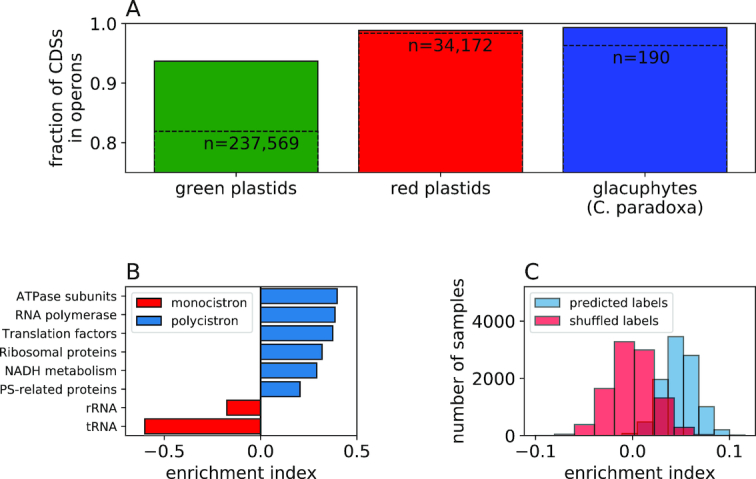
General traits of plastid primary transcripts. (A) The fraction of CDSs and total genes (dashed line) found in operons in green plastids, red plastids and glacuphytes. All differences return a non-significant empiric P-value of > \documentclass[12pt]{minimal}
\usepackage{amsmath}
\usepackage{wasysym} 
\usepackage{amsfonts} 
\usepackage{amssymb} 
\usepackage{amsbsy}
\usepackage{upgreek}
\usepackage{mathrsfs}
\setlength{\oddsidemargin}{-69pt}
\begin{document}
}{}$0.8$\end{document} (see ‘Materials and Methods’ section: Empiric P-value). The total number of genes sampled in each group is given above the relevant bar. The bars show mean ± SE. (B) Operon enrichment in different gene classes. Additionally, a hypergeometric enrichment/depletion P-value was computed for each group; P < 10−300 for all groups. (C) The distribution of functional enrichment in operons for 10 000 random samples shown in contrast to the same analysis carried on randomized data (see legend). Z-score and P-value (a two-tailed Wilcoxon test) between predicted labels and shuffled labels are 2.2 and \documentclass[12pt]{minimal}
\usepackage{amsmath}
\usepackage{wasysym} 
\usepackage{amsfonts} 
\usepackage{amssymb} 
\usepackage{amsbsy}
\usepackage{upgreek}
\usepackage{mathrsfs}
\setlength{\oddsidemargin}{-69pt}
\begin{document}
}{}$ < {10^{ - 300}}$\end{document}, respectively.